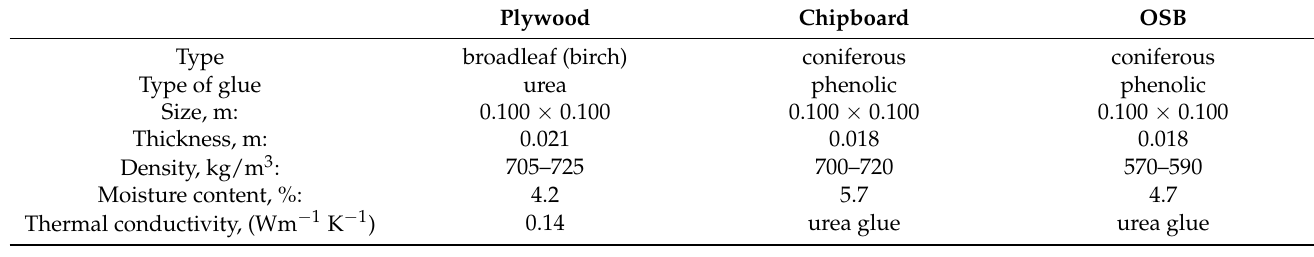
Table 1. Parameters of the samples.